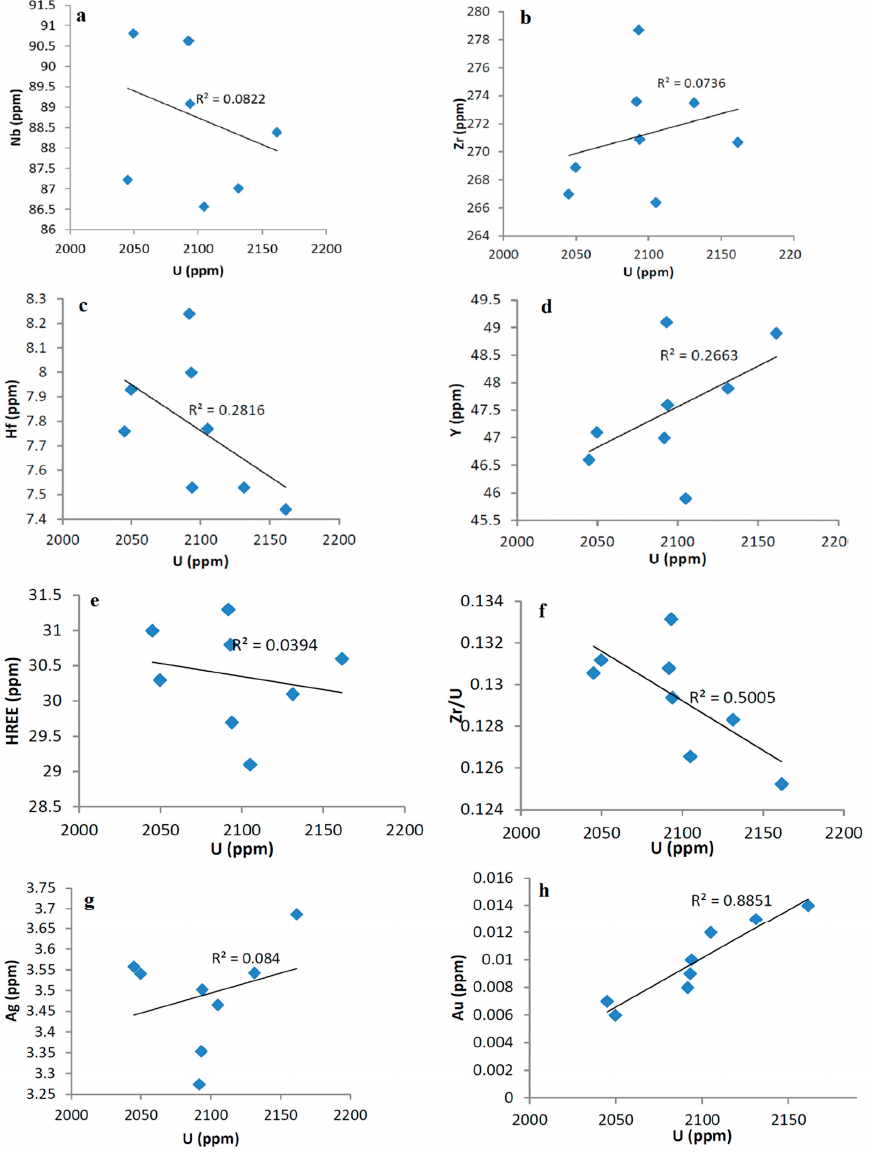
Figure 7. Variation diagrams of U and some trace elements ( a – h ). Blue squares mean altered granite Figure 7. VariationdiagramsofUandsometraceelements( a – h ). samples.